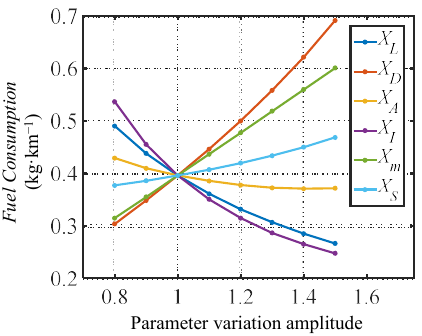
Figure 11. Influence of different influence factors on the fuel consumption.